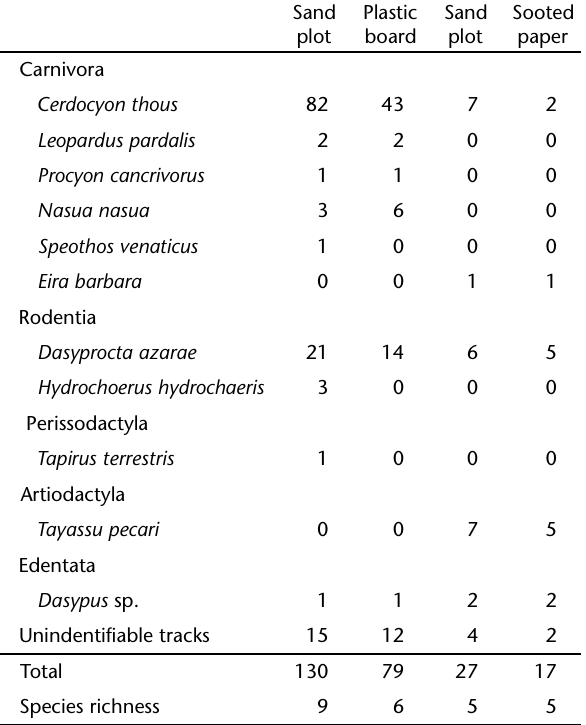
Table I. Mammal species registered in each tracking station-night placed in the Pantanal region, Brazil over 2002-2005. Species richness (number of species) and non-identifiable track records are also shown.